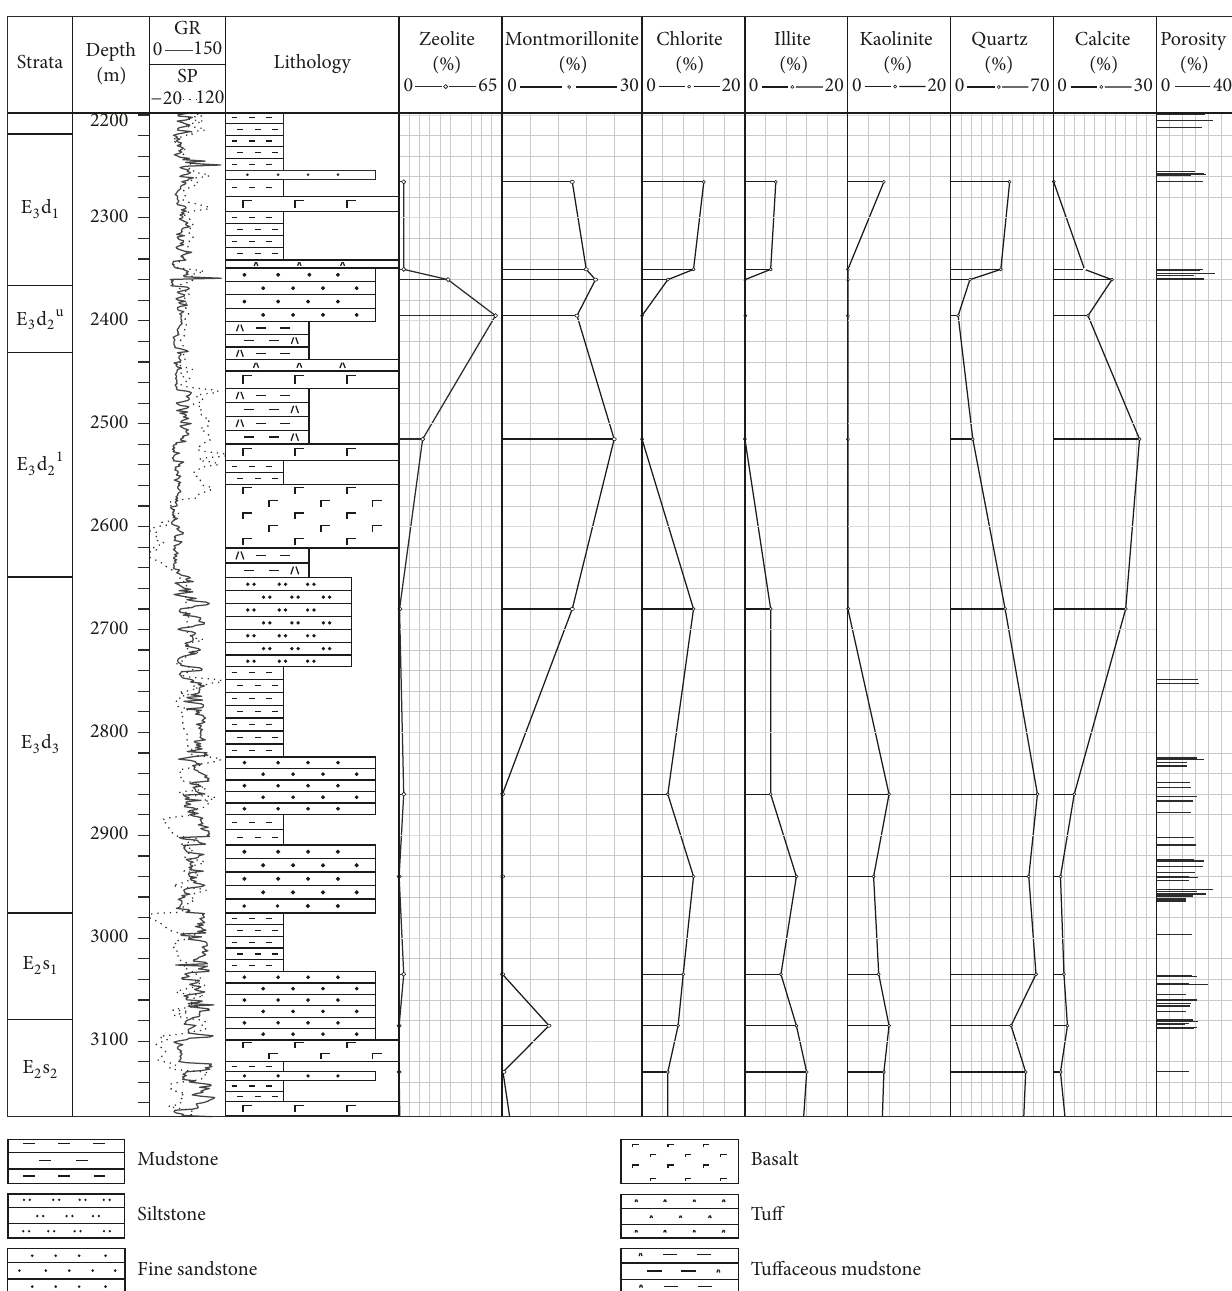
Figure 4: Mineralogical composition vertical distribution of reservoir sandstones in BZ-1 well based on X-ray diffraction (XRD)